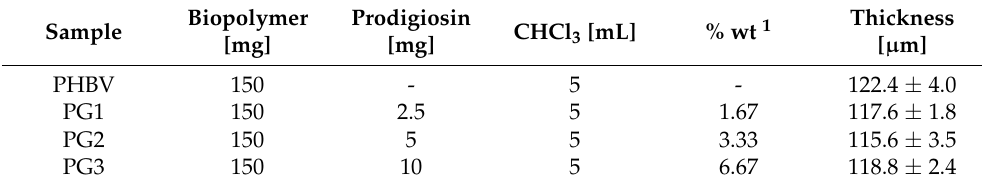
Table 1. Film sample abbreviations and corresponding